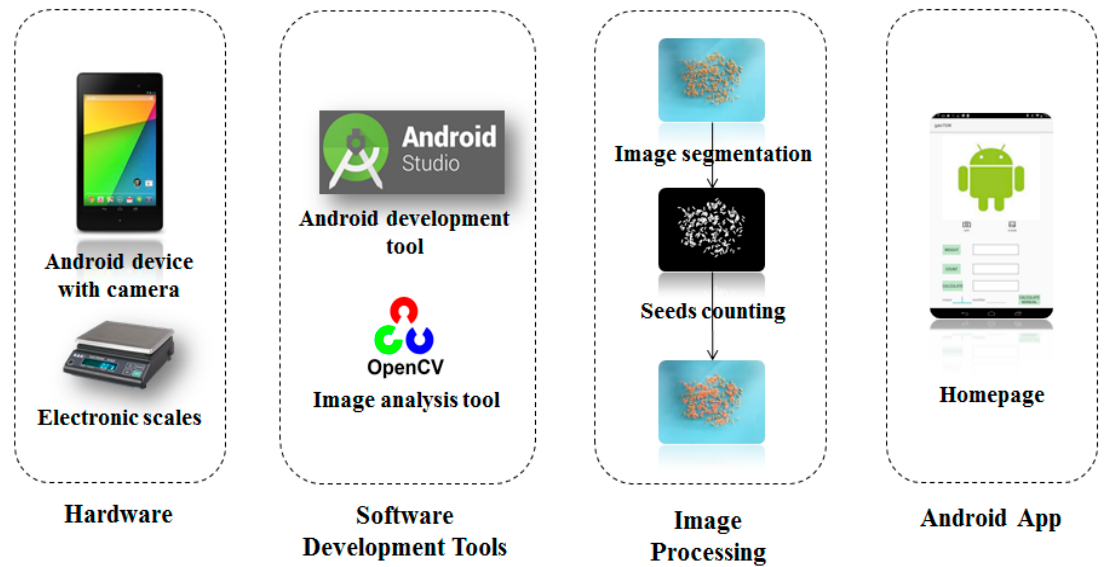
Figure 3. The system Implementation Flow. From left to right: hardware, programming tools, image process algorithm, software interface.